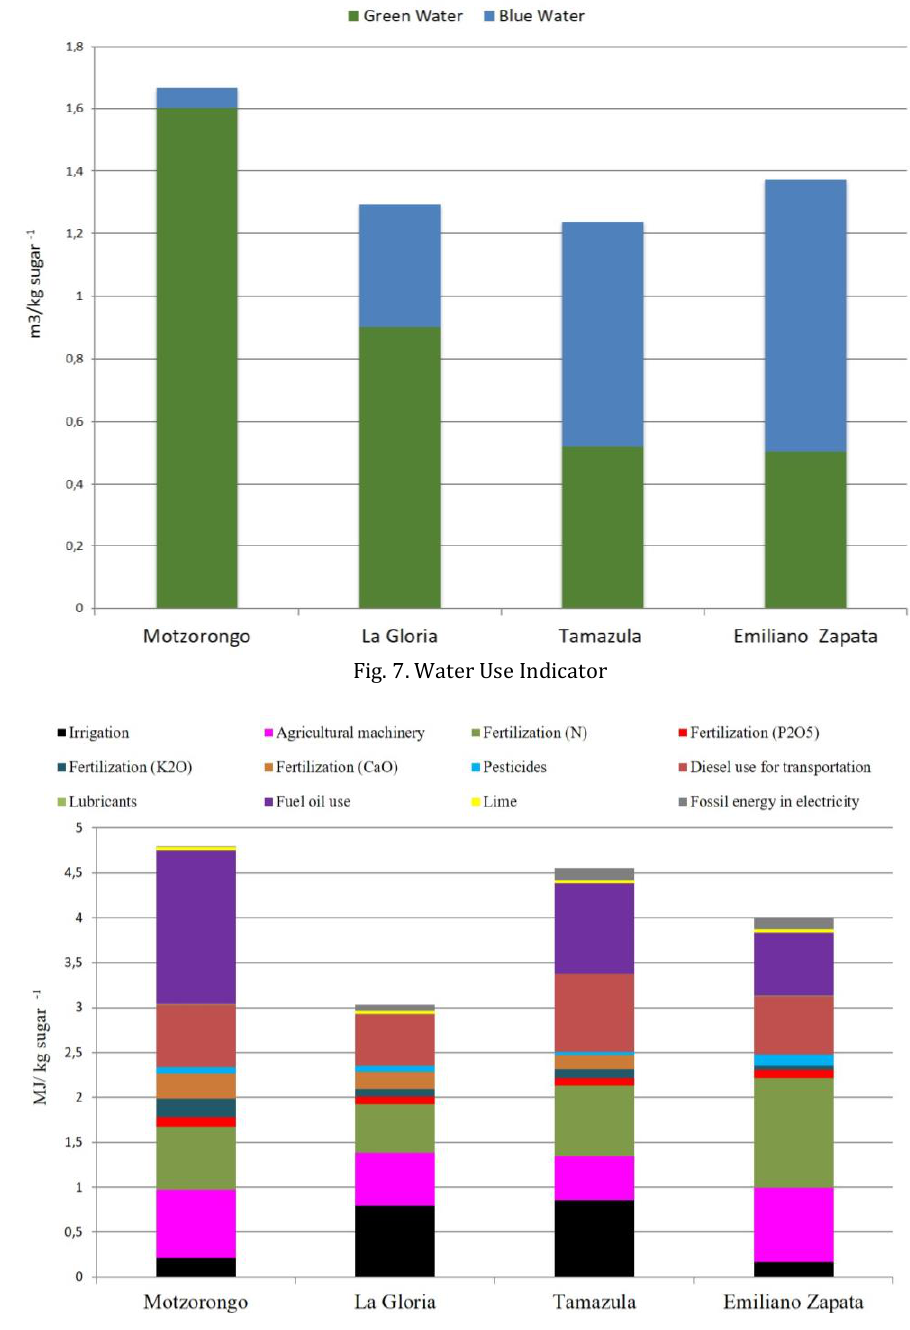
Fig. 8. Components of the Fossil Fuel Use